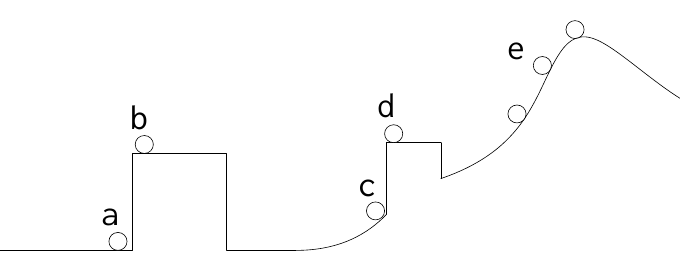
Figure 2. Light detection and ranging (LiDAR) points with different gradient characteristics.